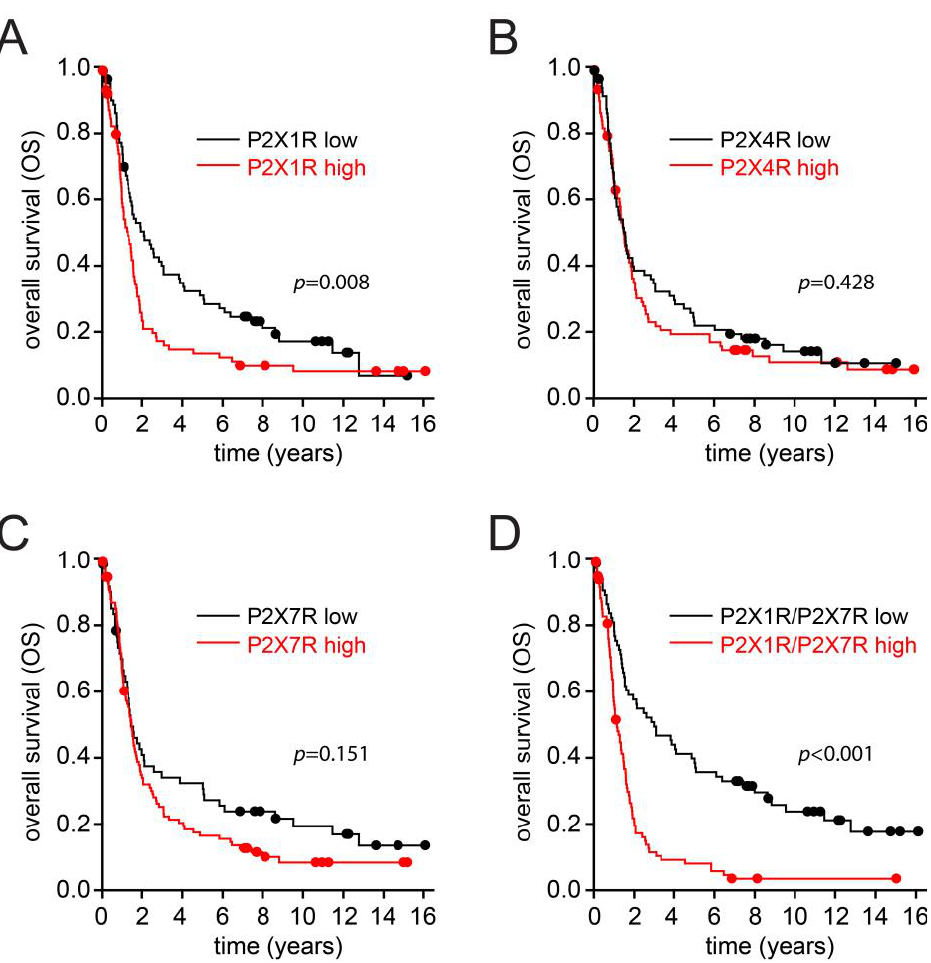
Figure 3. Effect of P2X receptor expression levels on overall survival in muscle-invasive bladder cancer (MIBC). Expression of P2X1R ( A ), P2X4R ( B ), P2X7R ( C ), and combined expression of P2X1R and P2X7R ( D ) was immunohistochemically analyzed in MIBC and scored as “low” (below median) or “high” (above median). Kaplan–Meier overall survival (OS) curves were plotted, and groups were compared by the log-rank test; ( A ) and ( B ): n = 171; ( C ): n = 172; ( D ): n = 170. 3.5. High Expression of P2X1 and P2X7 Receptors Is Associated with Reduced Tumor-Specific Survival Bladder-cancer-associated death occurred in 94 patients (54.34%,) and median TSS was 15.07 months. TSS in patients with high P2X1R expression (11.8 ± 10.0 months) was significantly lower than in patients with low P2X1R expression (16.4 ± 20.8 months; Figure 4A). P2X4R expression did not significantly affect TSS (Figure 4B). Patients with low